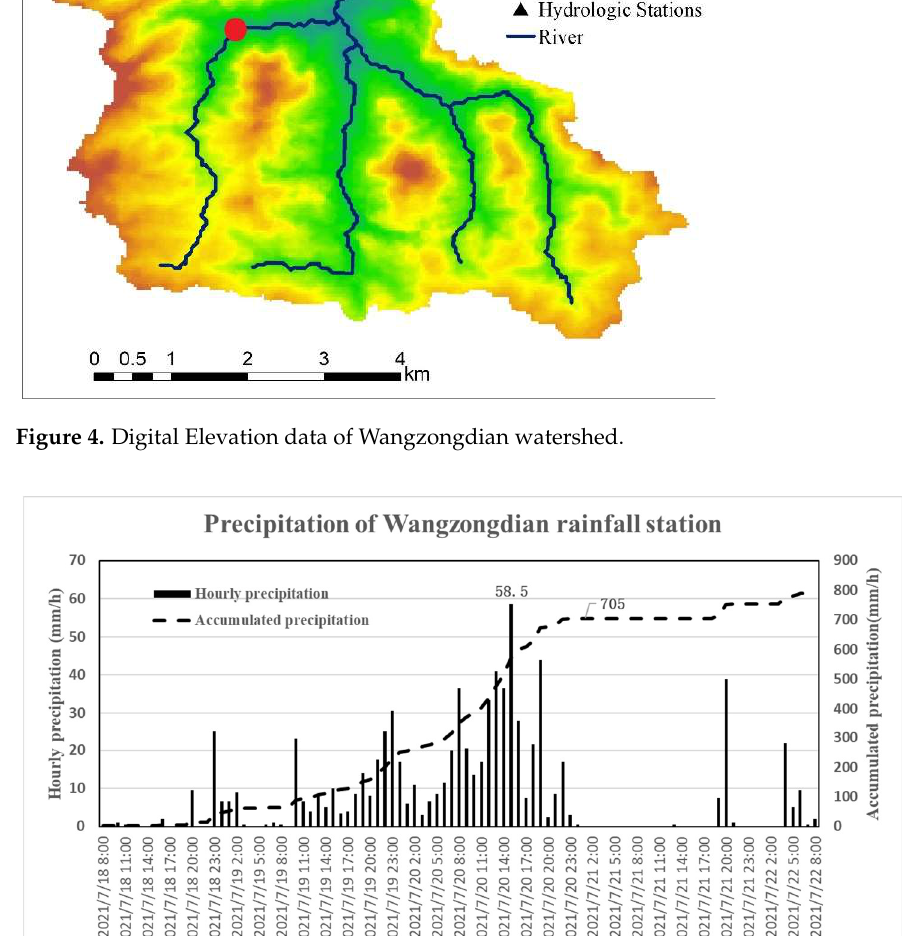
Figure 4. Digital Elevation data of Wangzongdian watershed.